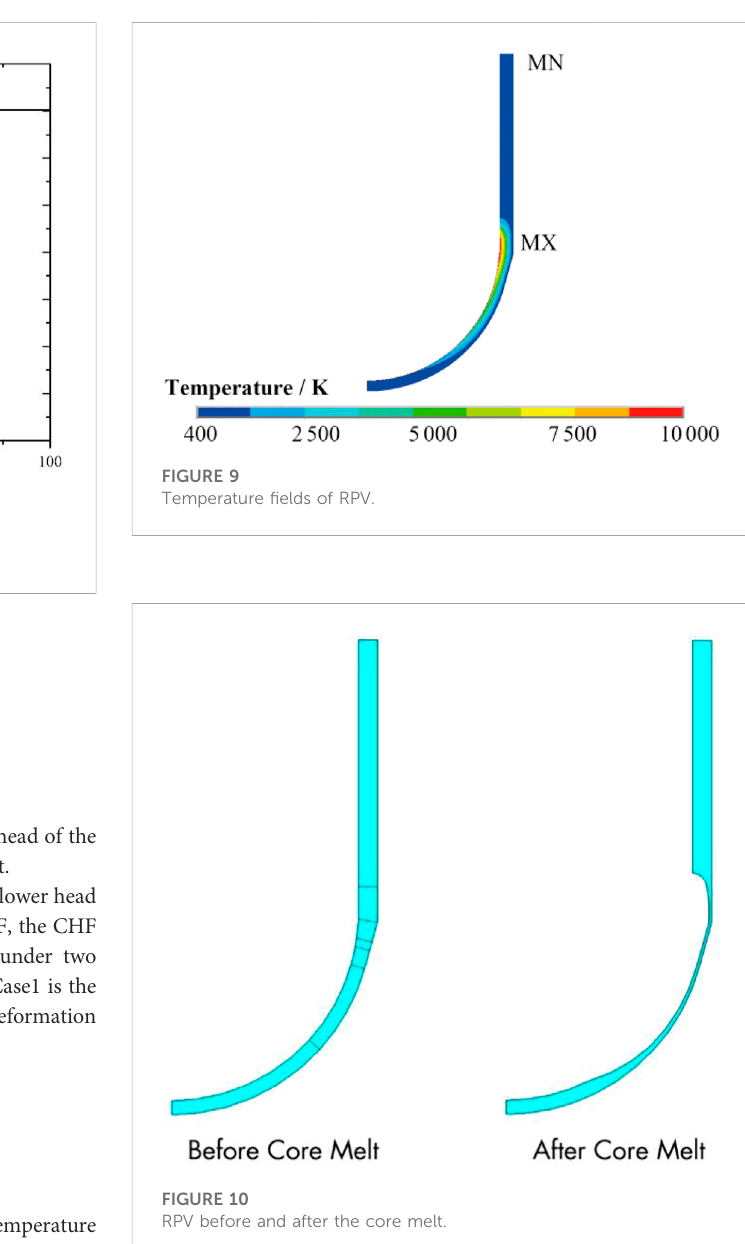
RPV before and after the core